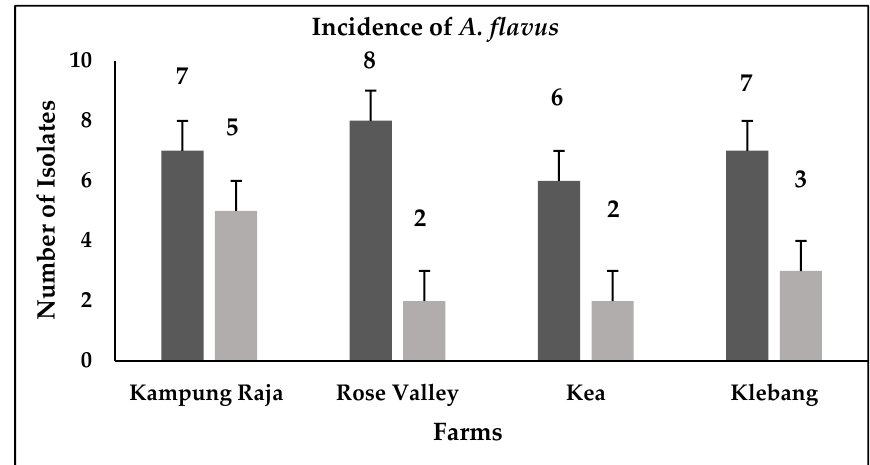
Figure 1. Prevalence of A. flavus isolates in Kampong Raja, Rose Valley, Kea, and Klebang farms; black bars = soil samples; grey bars = maize samples.